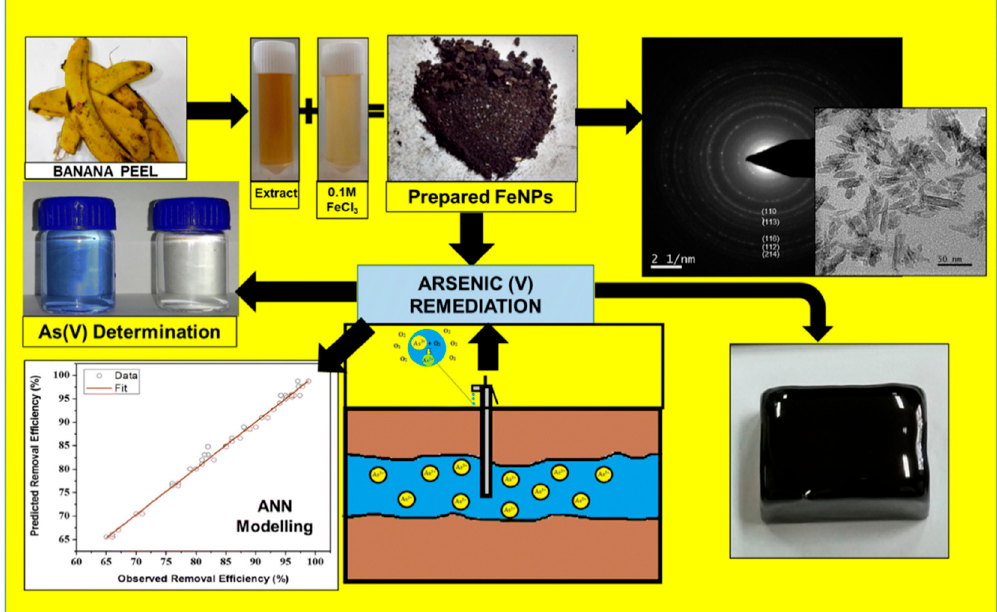
Figure 7. A schematic representation of the synthesis of Fe 3 O 4 and detection of arsenic [74]. Copyright 2019, reproduced with permission from Springer-Verlag GmbH, Heidelberg, Germany.